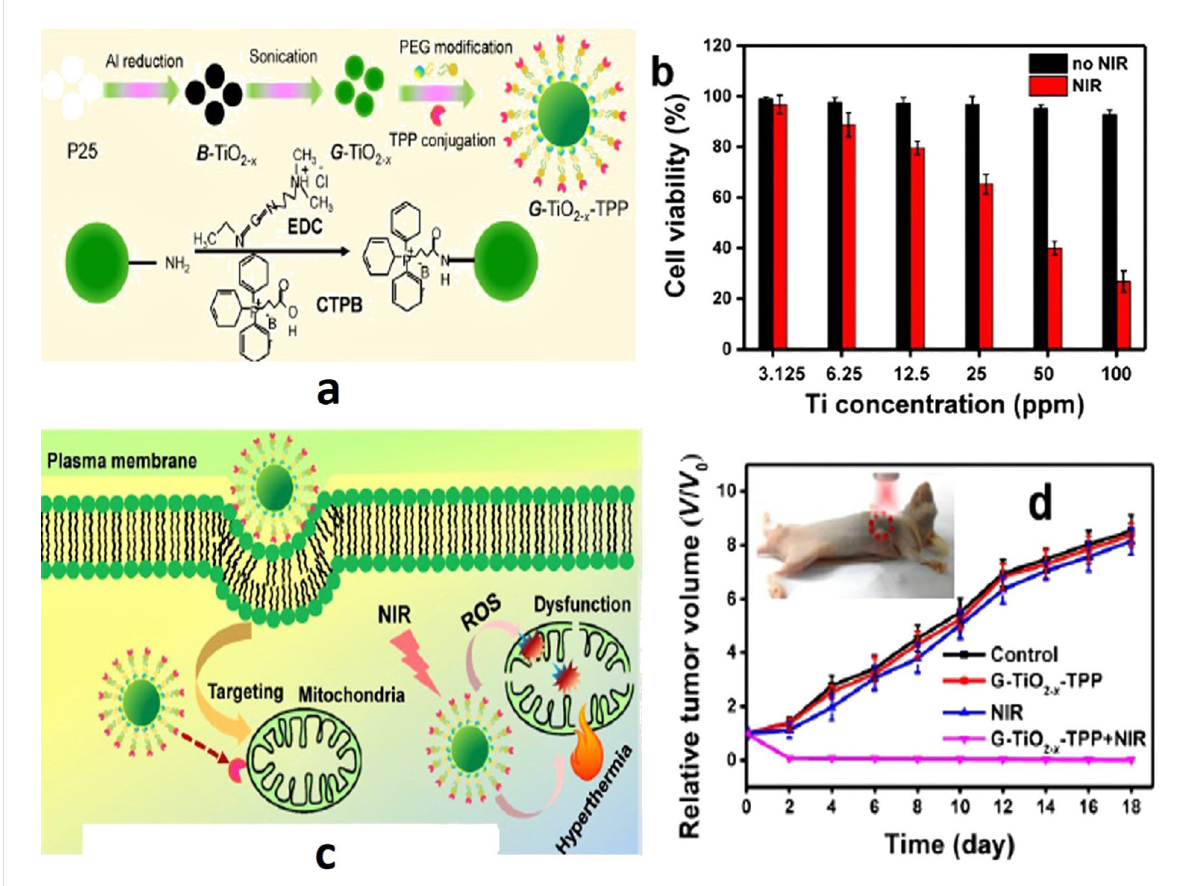
Figure 8: (a) Schematic representation of the preparation and surface modification of green titania (G-TiO 2 − x ) (section A) for (c) mitochondrial- targeted cancer phototherapy. First, black titania (B-TiO 2 − x ) was synthesized from P25 (pristine titania) through an aluminum reduction method. Then G-TiO 2 − x was prepared from B-TiO 2 − x by strong ultrasonication. Triphenylphosphonium (TPP) was conjugated to G-TiO 2 − x (G-TiO 2-x -TPP) for mito- chondria targeting. Under near-infrared (NIR) laser irradiation, G-TiO 2 − x was able to simultaneously generate reactive oxygen species (ROS) and hyperthermia for photodynamic therapy (PDT) and photothermal therapy (PTT), respectively. (b) In vitro cell viabilities (mean ± SD) of HeLa cells incu- bated with G-TiO 2 − x at different Ti concentrations for 24 h without (black bars) and under NIR laser irradiation for 5 min (red bars, 980 nm, 0.72 W·cm − 2 ). (d) Tumor growth curves of different groups of tumor-bearing mice. The inset shows a photograph of cancer phototherapy (Figure 8 was adapted from [116] (© 2017 Ivyspring International Publisher, published by Ivyspring International Publisher, distributed under the terms of